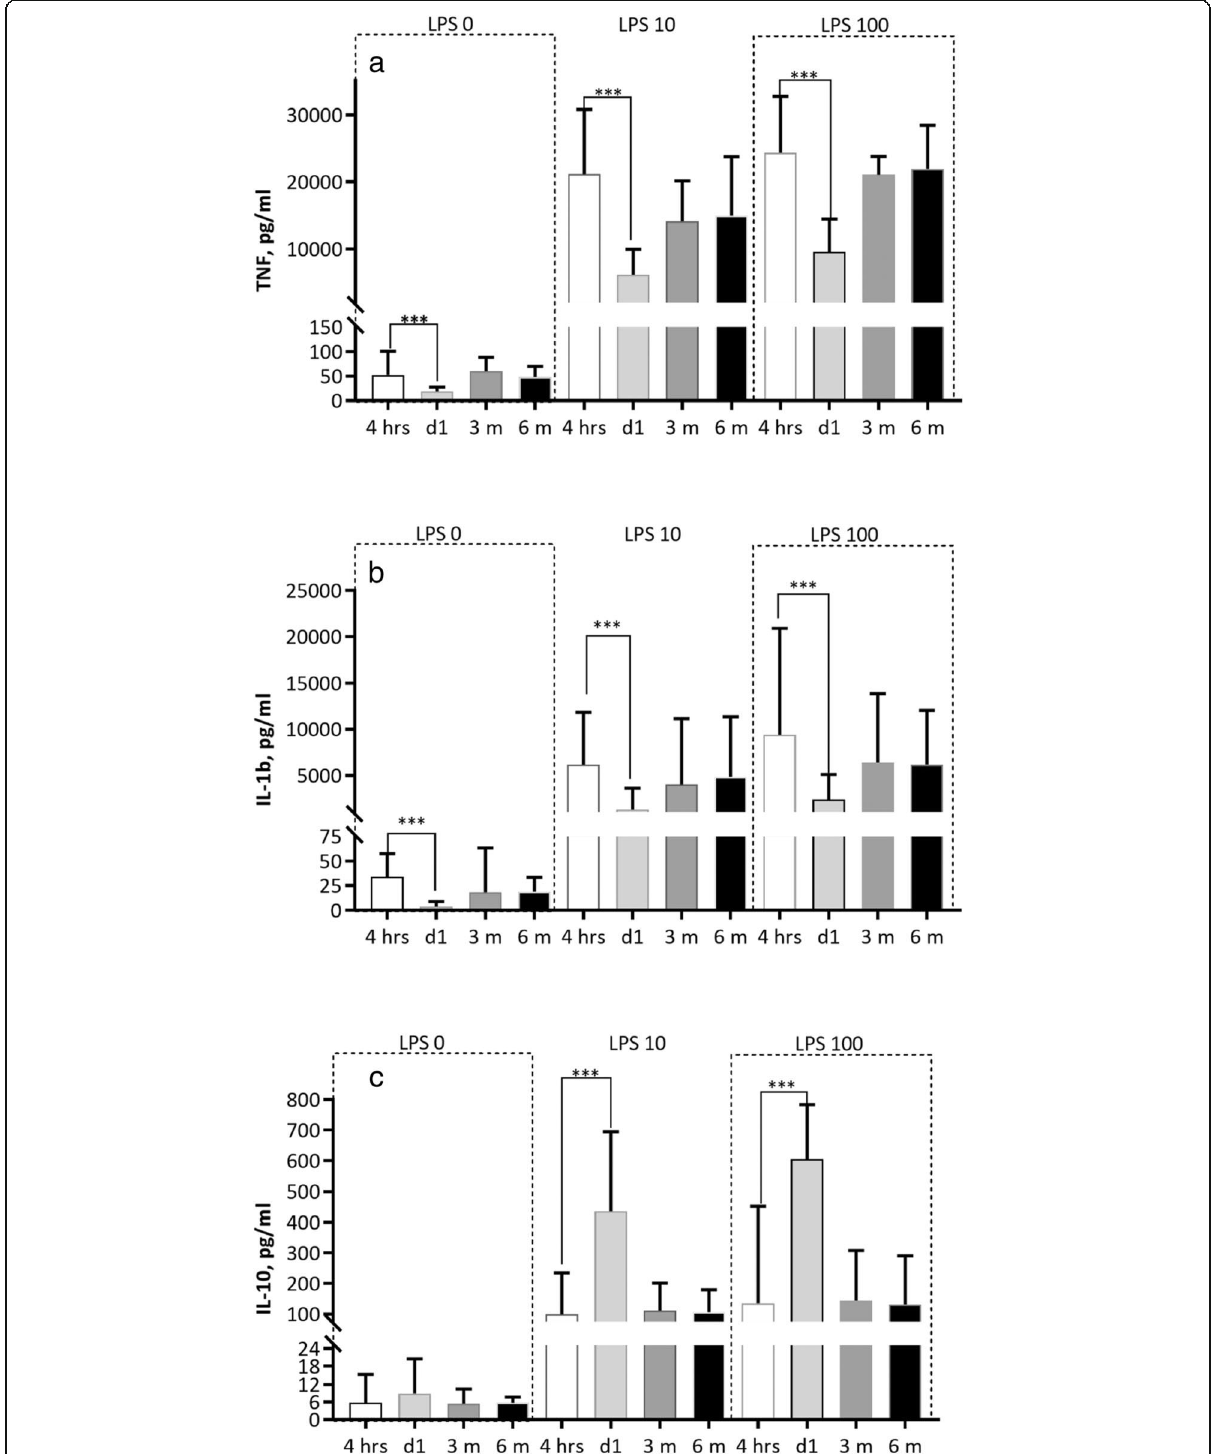
Fig. 2 RDN. Whole blood stimulated with LPS-concentrations 0, 10 and 100 ng/mL. Plasma levels of cytokines (after 4 hours incubation at 37C ˚ ) before RDN at 1 day after RDN and at 3 and 6 months follow up. TNF ( a ), IL-1b ( b ), IL-10 ( c ). *** p < 0.005. Data presented as median and (10-90)